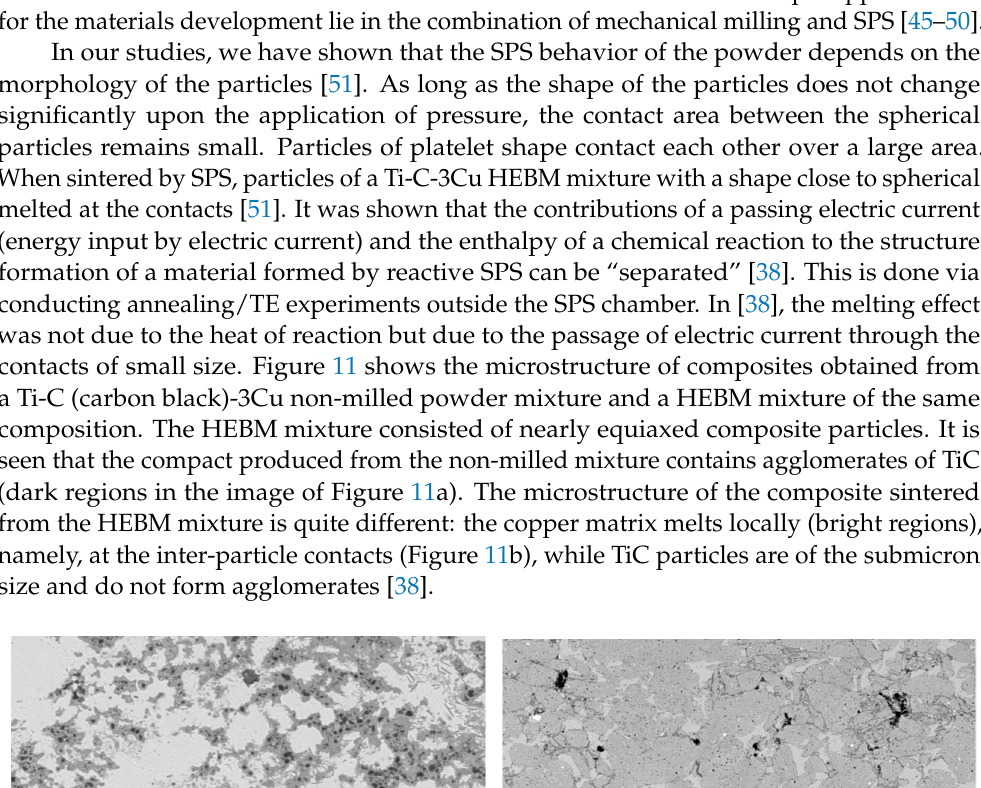
( b ) Figure 12. Microstructure (BSE image) of the Fe-Ag pseudo-alloy obtained by SPS of the HEBM powder ( a ), morphology (SE image) of porous silver obtained by selective dissolution of iron from the sintered Fe-Ag pseudo-alloy ( b ). Reprinted from [53], Copyright (2022), with permission from Elsevier.